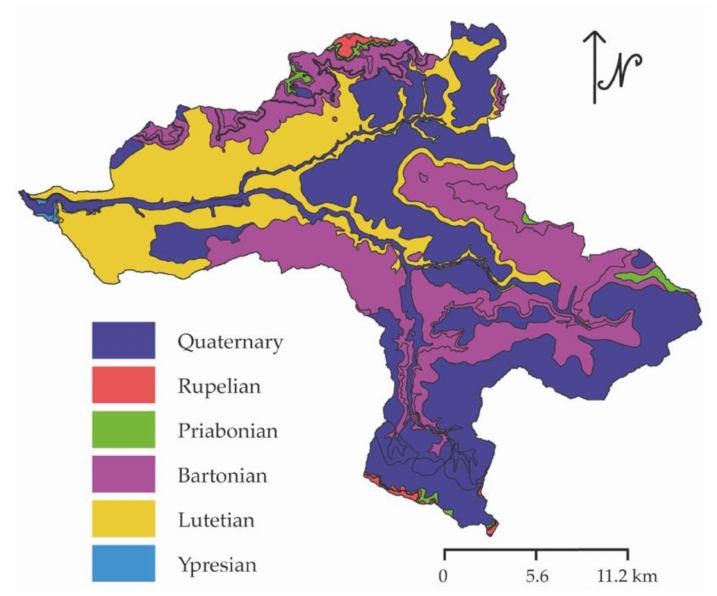
Figure 3. Geological map of the Nonette